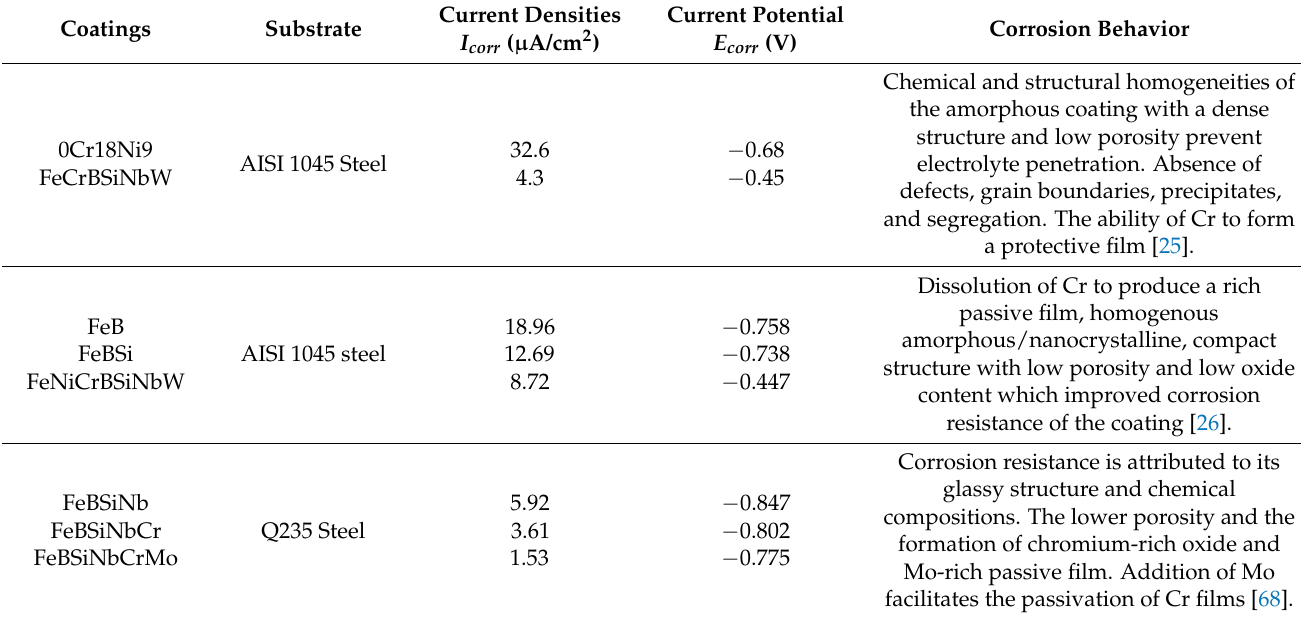
Table 3. Summary of the corrosion properties of Fe-based